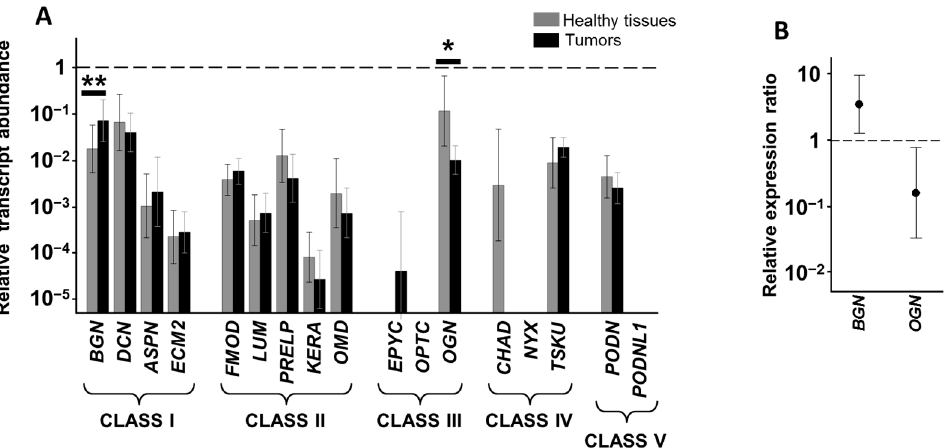
Figure 1. Differential transcription of SLRP genes in RSCC. ( A ) Relative transcript abundance of mRNAs for SLRPs, grouped by class. Relative abundance for healthy tissues (gray bars) and tumors (black bars) are plotted on a log scale for each gene assayed and spreads represent standard deviation. Statistically significant differences are denoted by **, and *, which indicate p < 0.01, and p < 0.05, respectively. ( B ) Relative expression ratio of genes that show statistically significant differences; the values represent the relationship between the transcription levels observed in each tumor tissue versus healthy tissue from the same patient. Values on the Y axis are represented on a logarithmic scale.